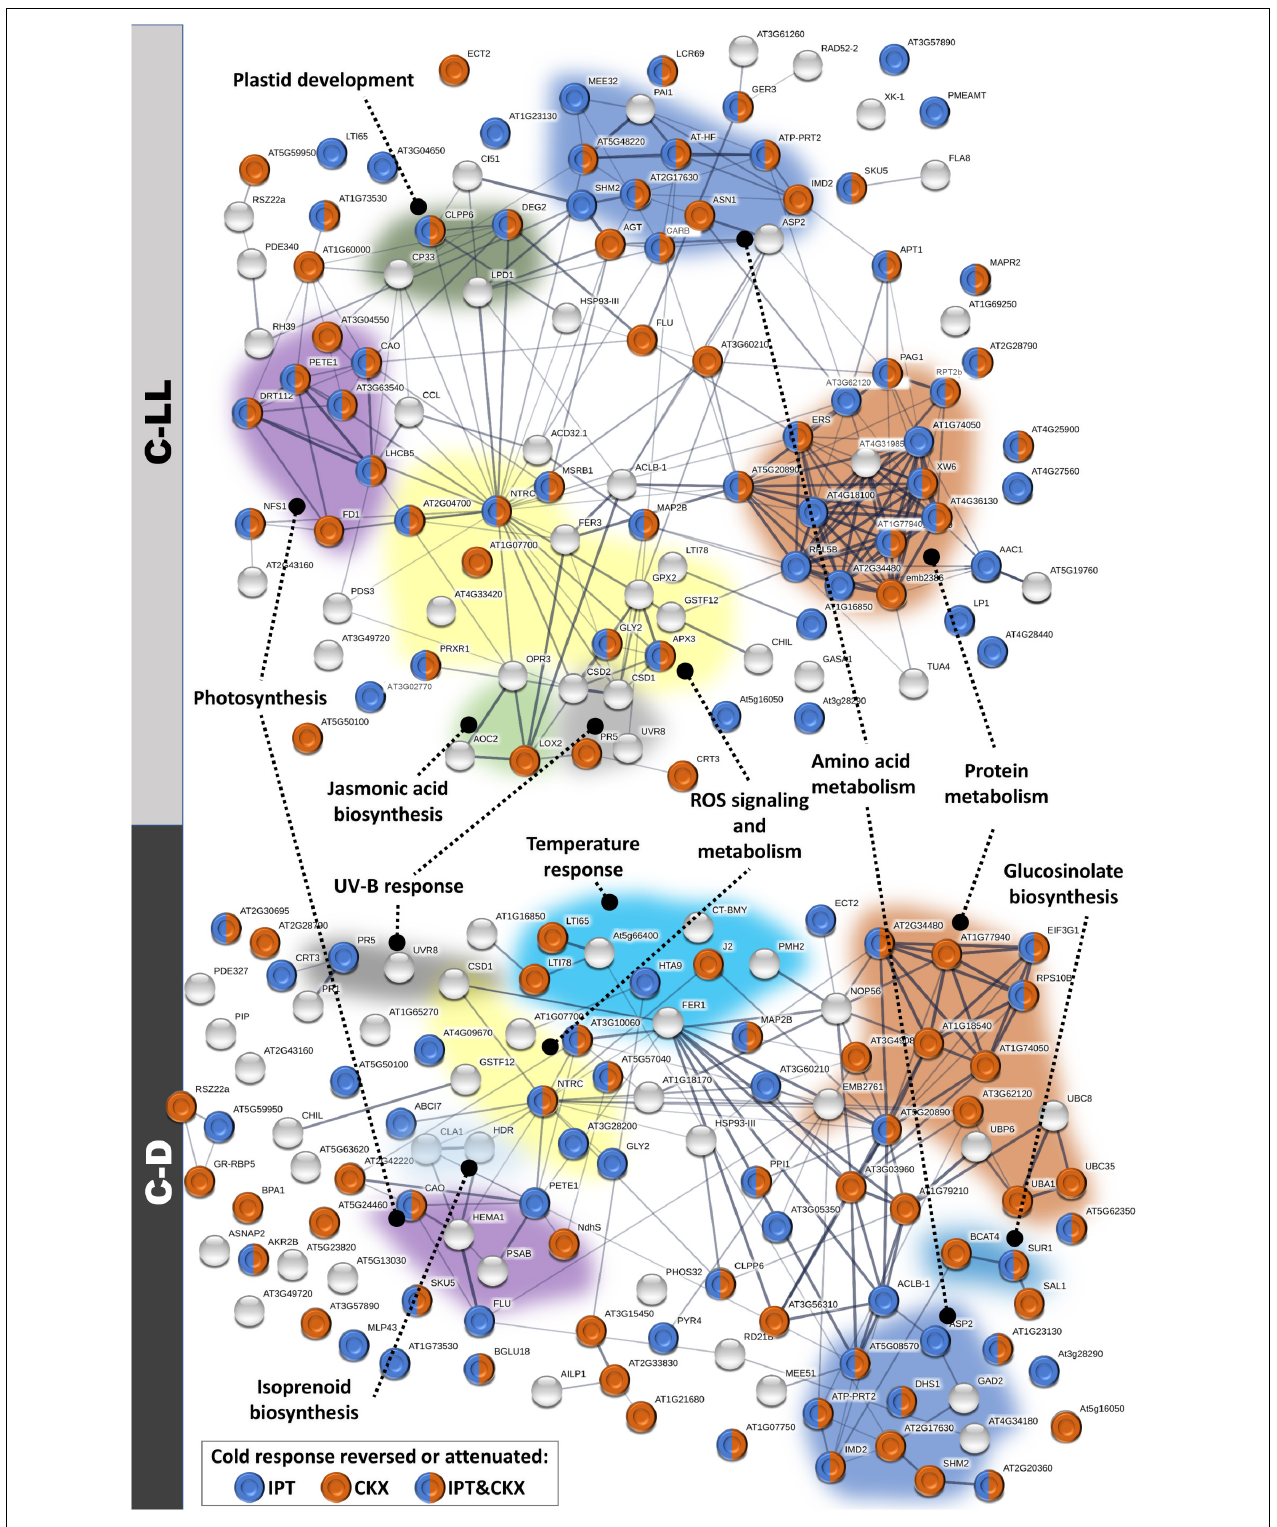
FIGURE 8 | Modulation of cold-responsive proteins in plants with an altered cytokinin pool. Interactions and functional clusters of identified cold-responsive proteins (compared to control, 20 ◦ C, 150 µ mol m − 2 s − 1 ; p < 0.05) were highlighted by String (Szklarczyk et al., 2019). The line thickness indicates the strength of data support, and the minimum required interaction score is 0.4 (medium confidence). See proteomic data in ProteomeXchange for details.